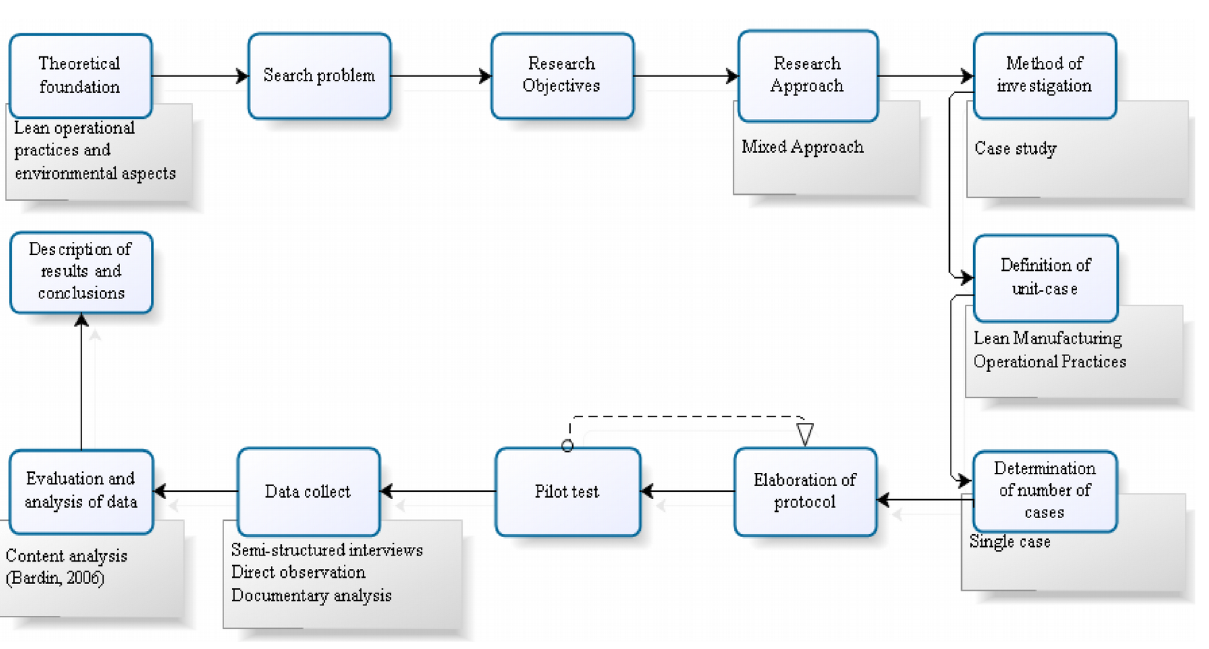
Figure 1. Methodological